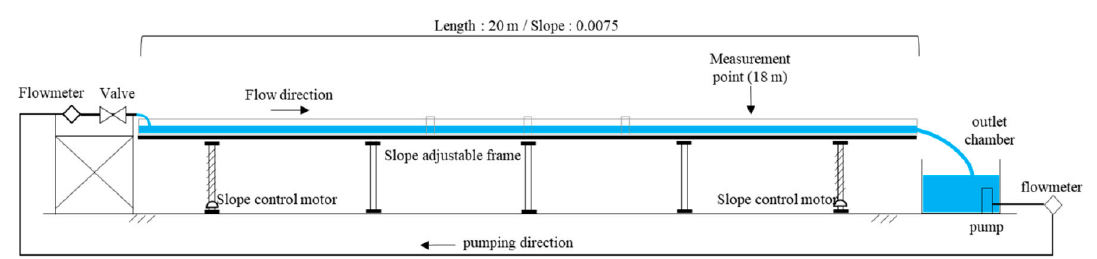
Figure 4. Schematic drawing of the experimental sewer pipelines for particle transportation.